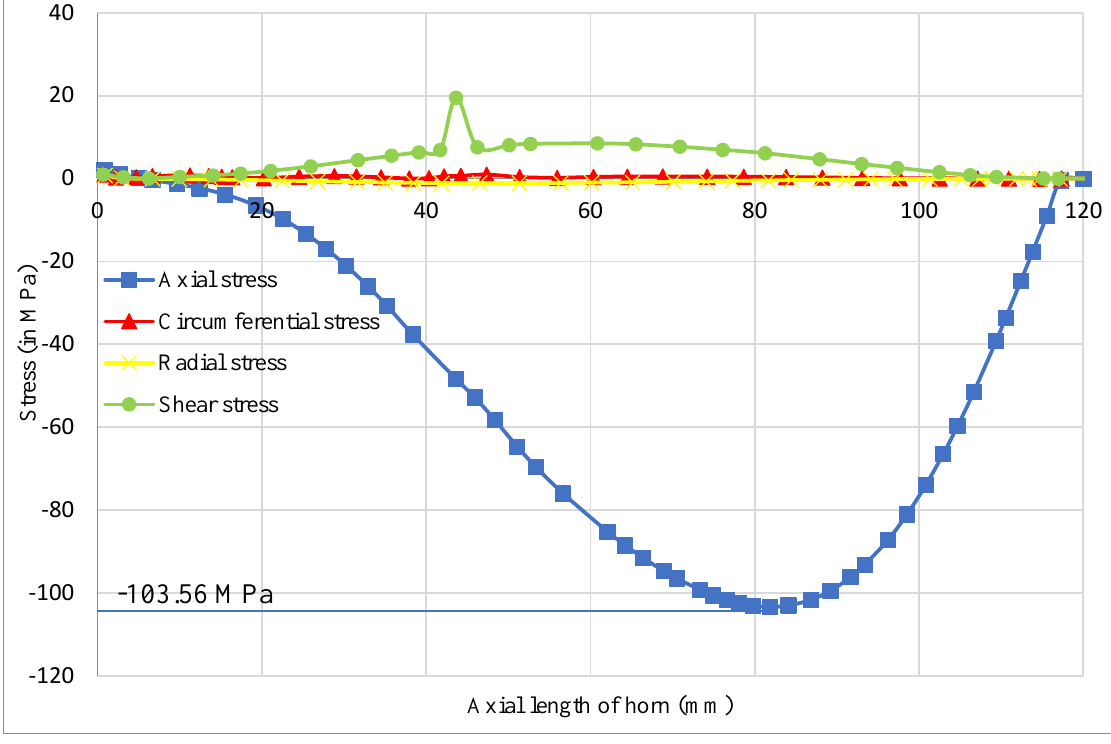
Figure 12. Stress variation along the axial length of aluminium catenoidal